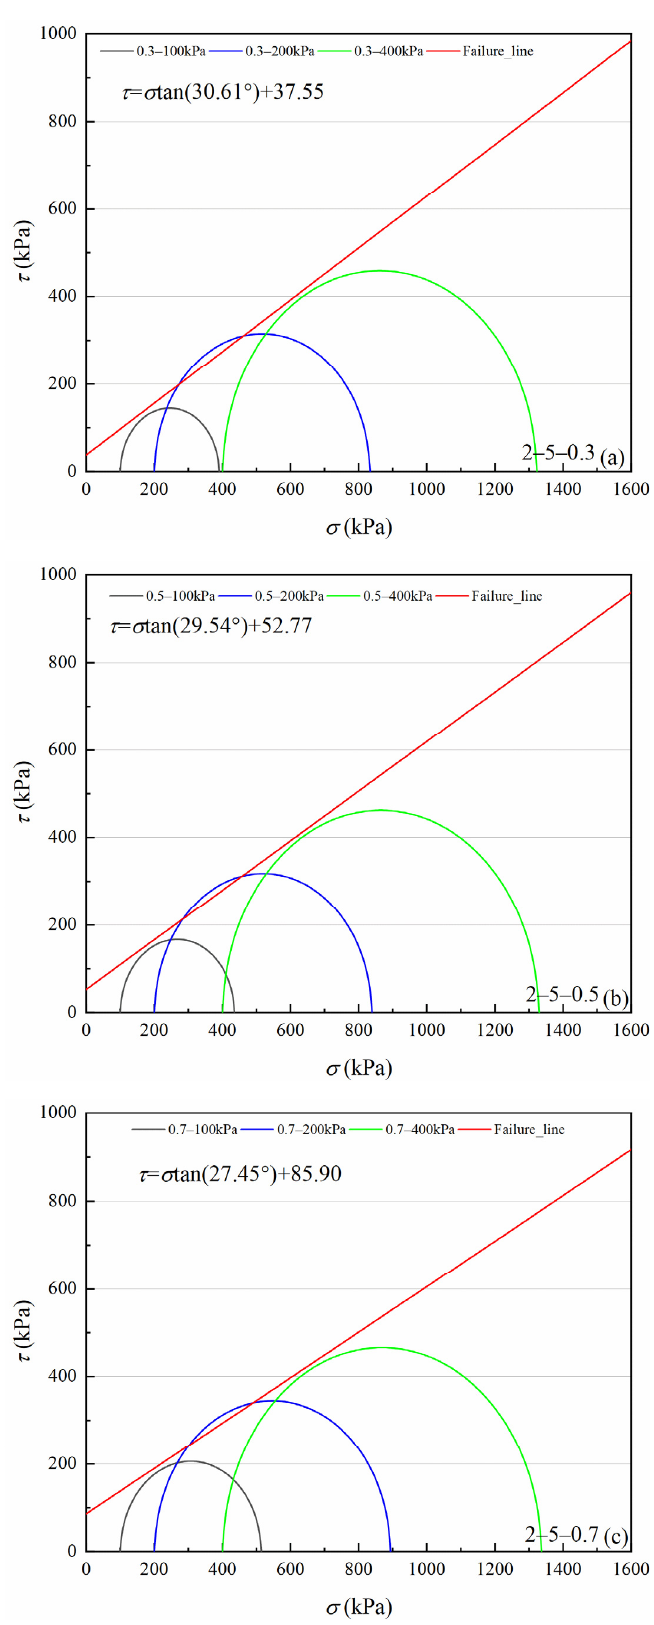
Figure 7. Shear strength envelopes of 2–5 mm particle groups volcanic soil with different relative density ( Dr ) under the peak state: ( a ) Dr = 0.3, ( b ) Dr = 0.5, ( c ) Dr = 0.7.